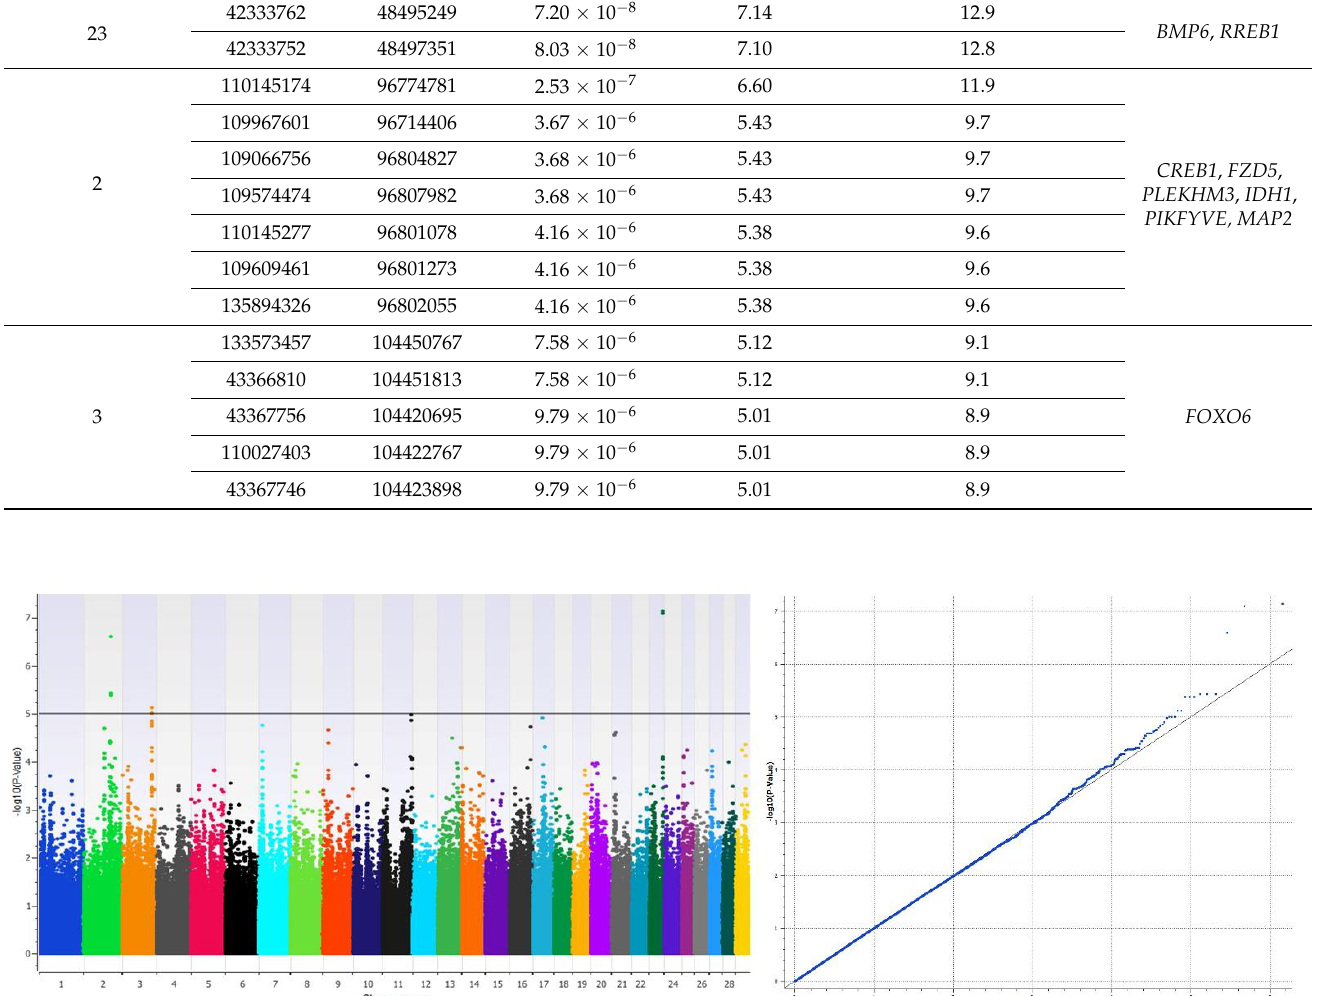
Table 1. Chromosome, rs number, position, p -value, −log( p -value), percentage of variance explained, and the candidate genes for significant SNPs associated with the AFC.